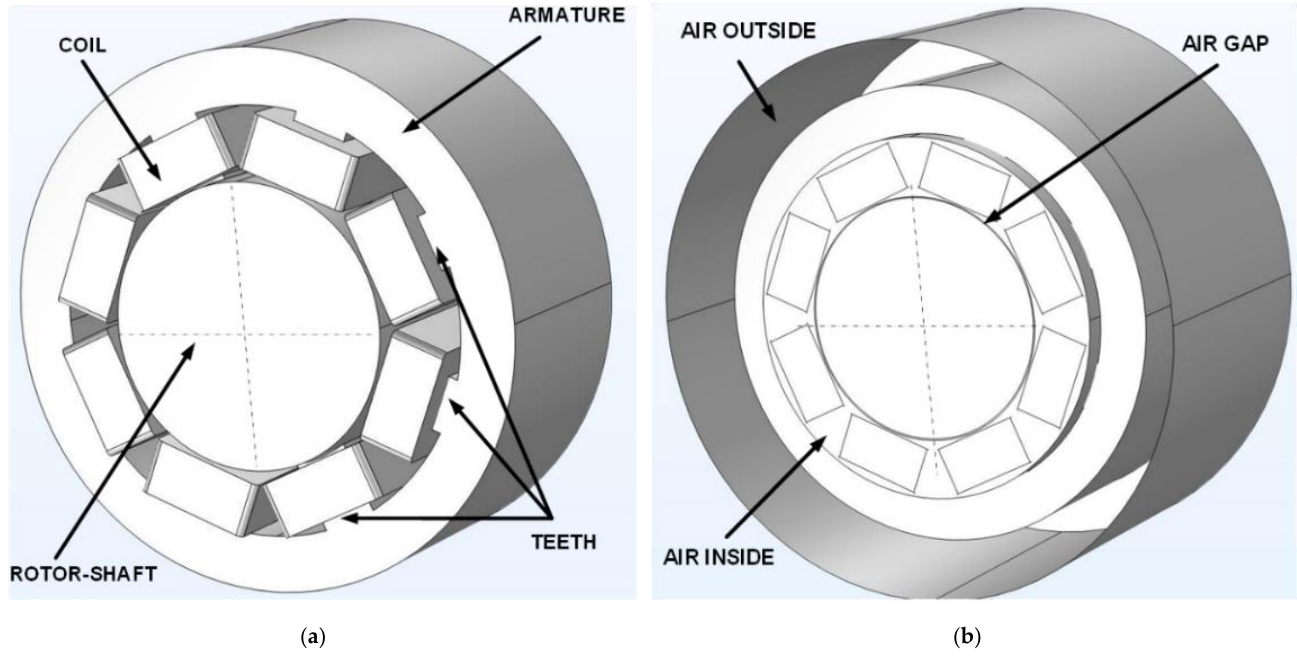
Figure 3. The geometrical shapes of the radial magnetic bearing components – magnetic circuits (a) air zones in the model (b).